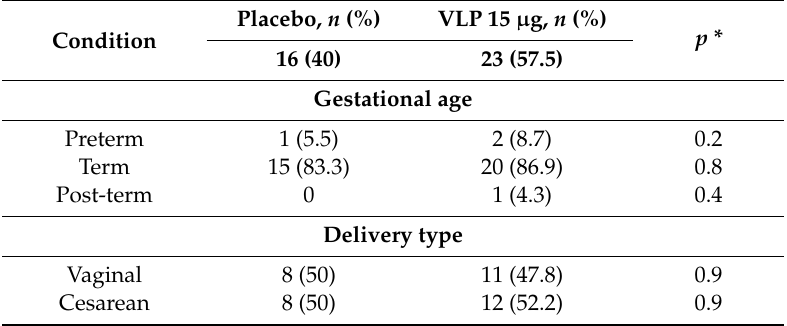
Table 2. Gestational age and delivery type in the placebo and 15 mg VLP vaccine groups.